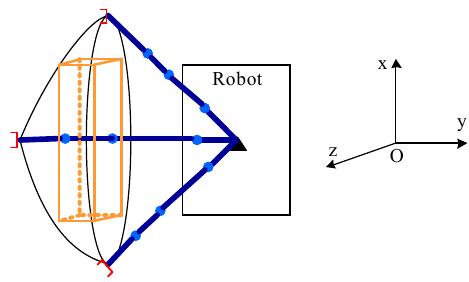
Figure 4. Operational area for automatic picking of tomatoes in the greenhouse.